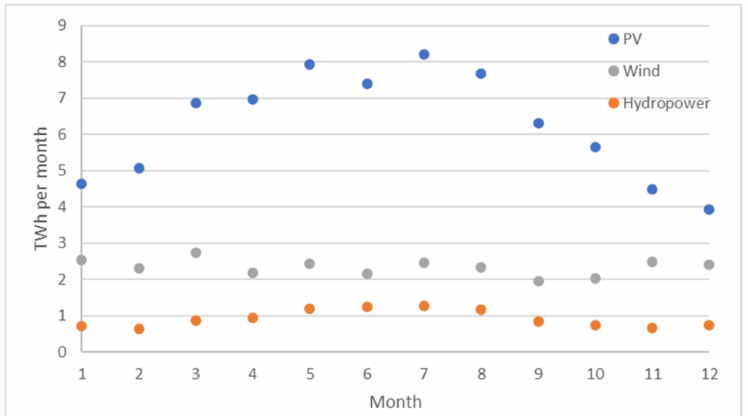
Figure 14. Incremental electricity generation in 2050 compared with 2019 over the course of the year for